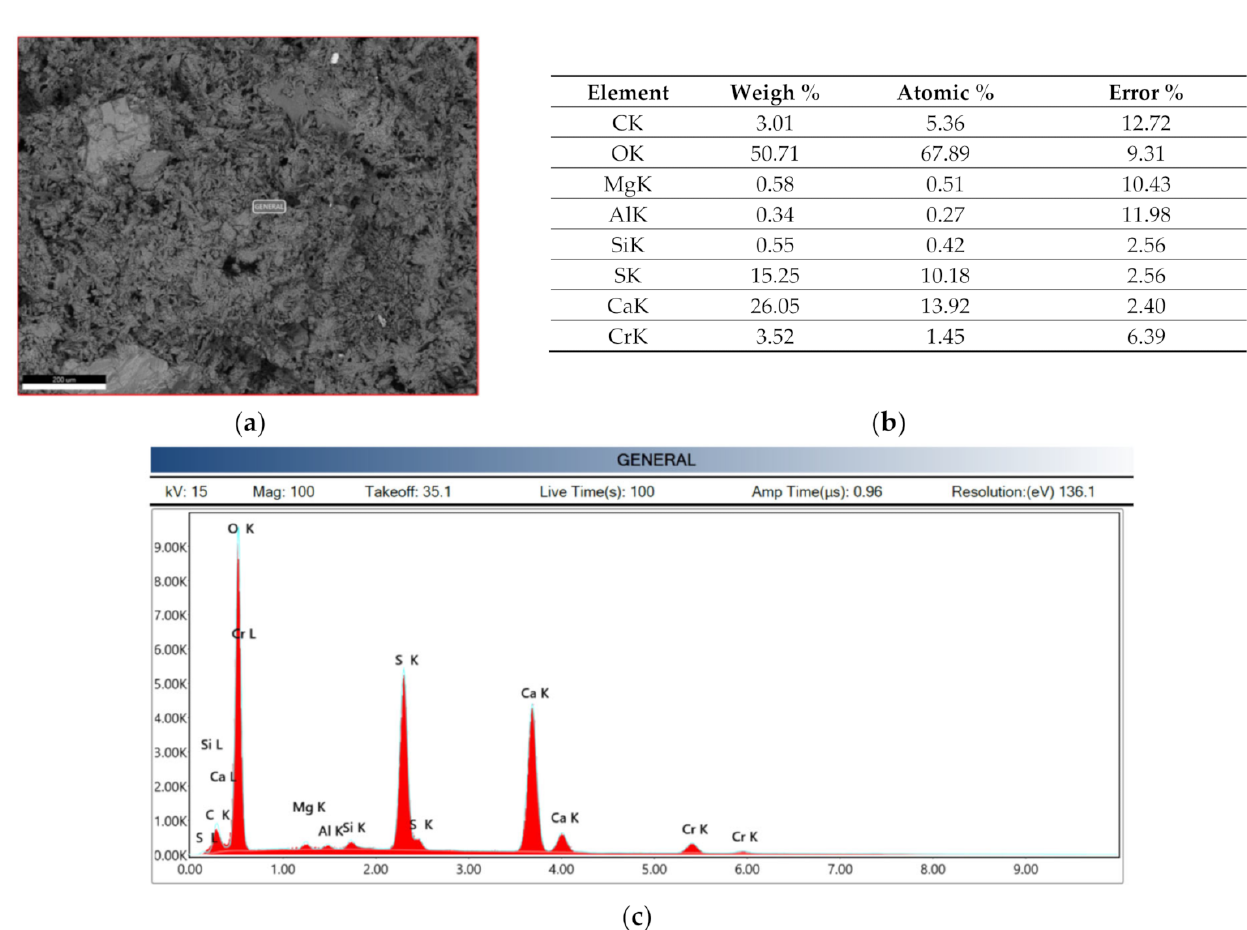
Figure 21. Analysis area and results for the compound containing polycarbonate salts with calcium sulfate, showing the general sample area and X-ray spectrograph (source: the author): ( a ) micrograph of gypsum with polycarbonate salts; ( b ) chemical composition; ( c ) chemical composition of gypsum with polycarbonate salts.